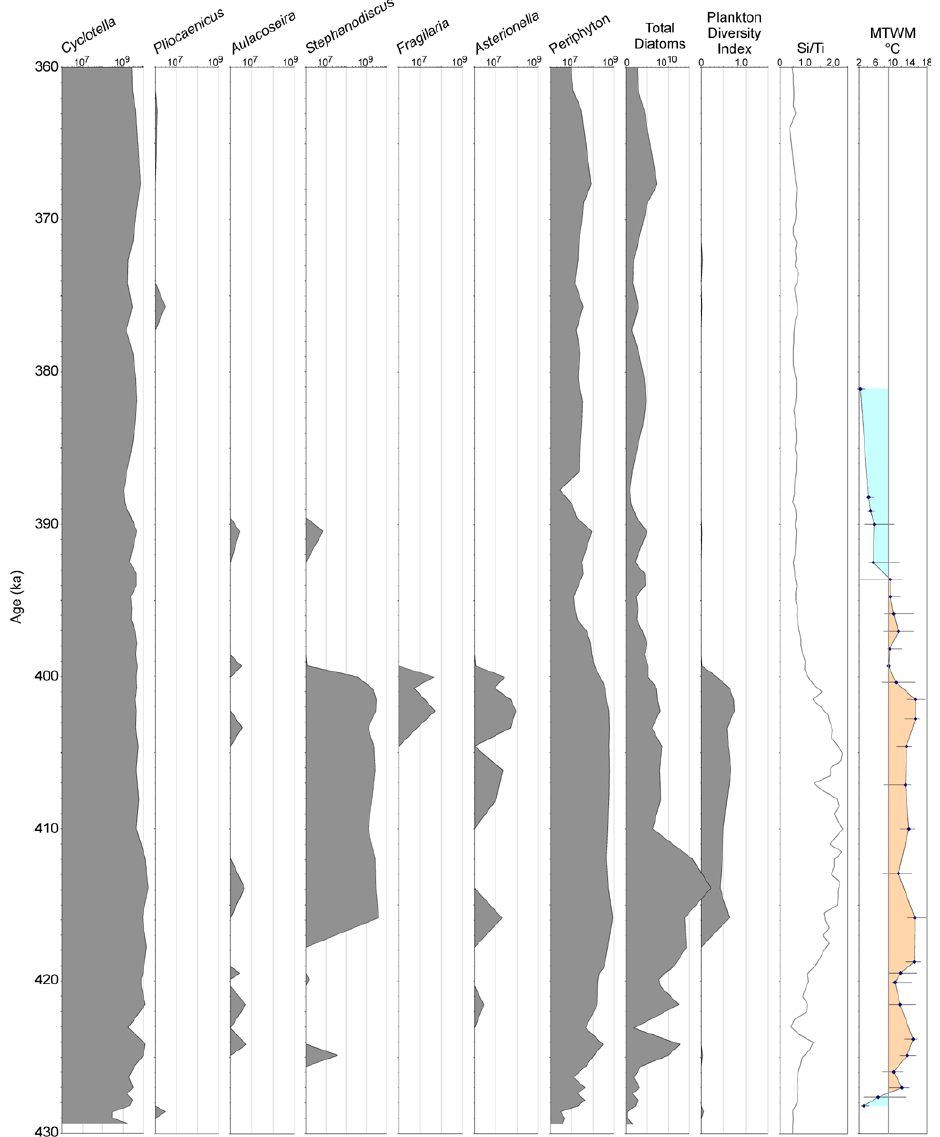
Fig. 5. Concentration (valves g − 1 ) of planktonic species, total periphyton, total diatoms, and plankton diversity (Shannon index) from 360 to 430ka. Other El’gygytgyn climate proxies from Melles et al. (2012) are included for comparison (see Fig.